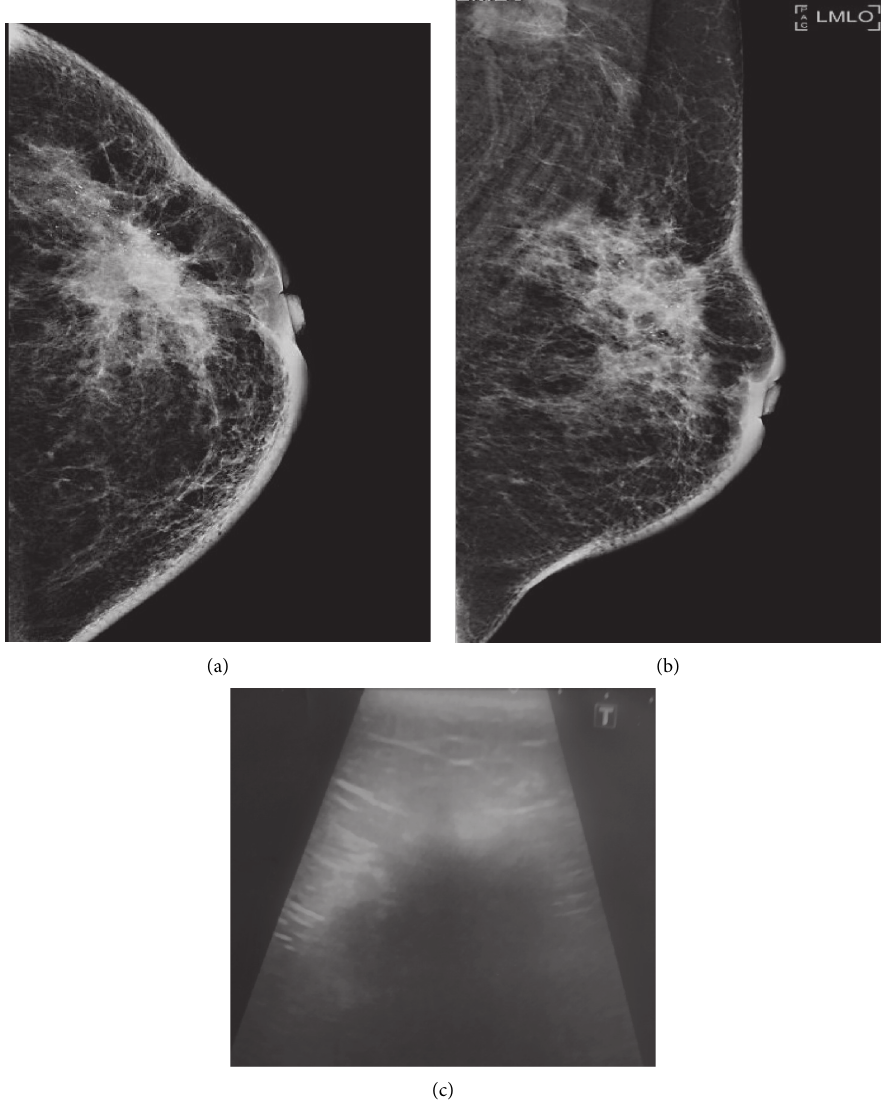
Figure 2: CC and MLO views of left breast: biopsy-proven hormone receptor +ve tumor (grade II). (a) A high-density mass is seen in upper- outer quadrant extending to retroareolar region. Irregular spiculated margins are seen with secondary signs of architectural distortion and trabecular thickening. (b) Overlying skin shows thickening and dimpling. Clustered microcalcifications are also seen within the mass. We can also see large malignant looking nodal mass in ipsilateral axilla. (c) Ultrasound of the same patient: there is a hypoechoic mass with irregular spiculated margins. Dense posterior acoustic shadowing is also seen obscuring posterior extent of the mass. We can also appreciate antiparallel orientation and peripheral echogenic halo. Sono-mammometry score �